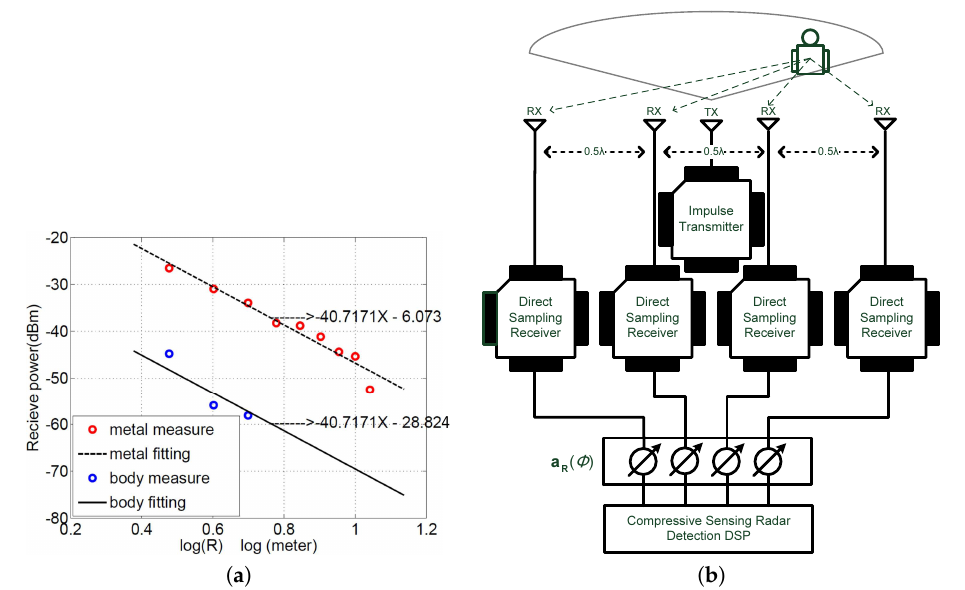
Figure 3. ( a ) Single-input multiple-output (SIMO) radar configuration and ( b ) the measured path loss models of the human body and metal